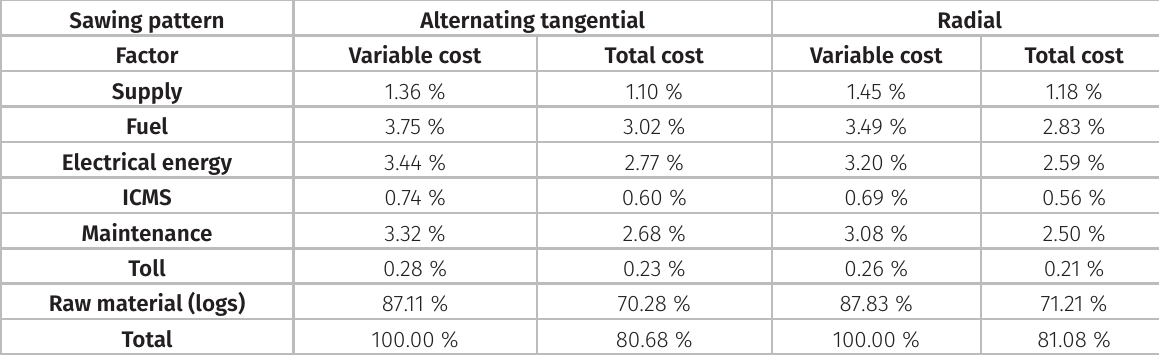
Table III. Percentage of total variable costs for the alternating sawing pattern and radial sawing pattern. Sawing